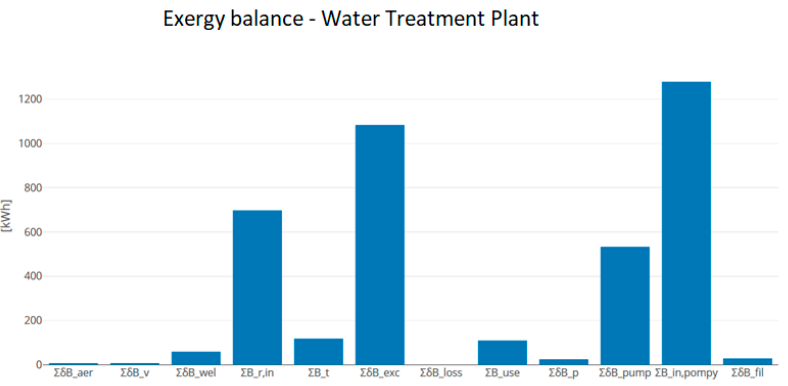
Figure 14. Exergy balance for the water treatment plant.